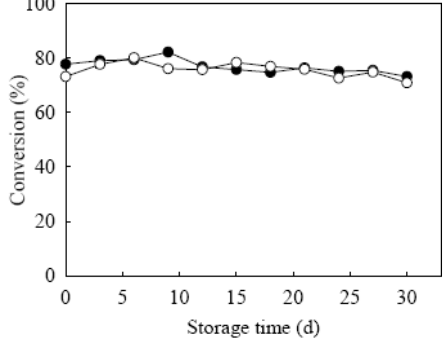
Figure 4. Storage stability of Pseudomonas cepacia lipase entrapped in biomimetic silica. Room temperature ( ● ); 4 °C ( ○ ). Fifty milligrams of entrapped lipase were sampled